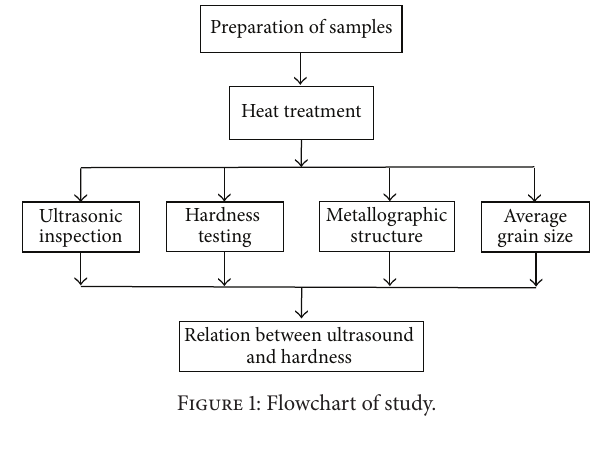
Figure 1: Flowchart of